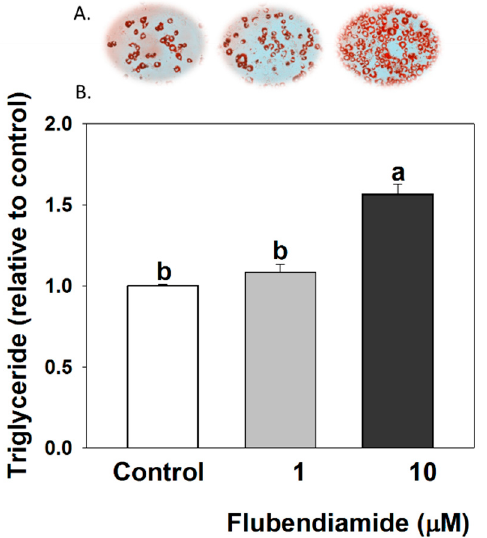
Figure 1. Flubendiamide treatment increased triglyceride accumulation in 3T3-L1 adipocytes. Cells were treated with flubendiamide for 8 days. ( A ) Oil red O staining; ( B ) triglyceride quantification with kit. Each value is expressed as the mean ± standard error of three separate experiments. Means with different letters were significantly different at p < 0.05 (a vs. b is significantly different).